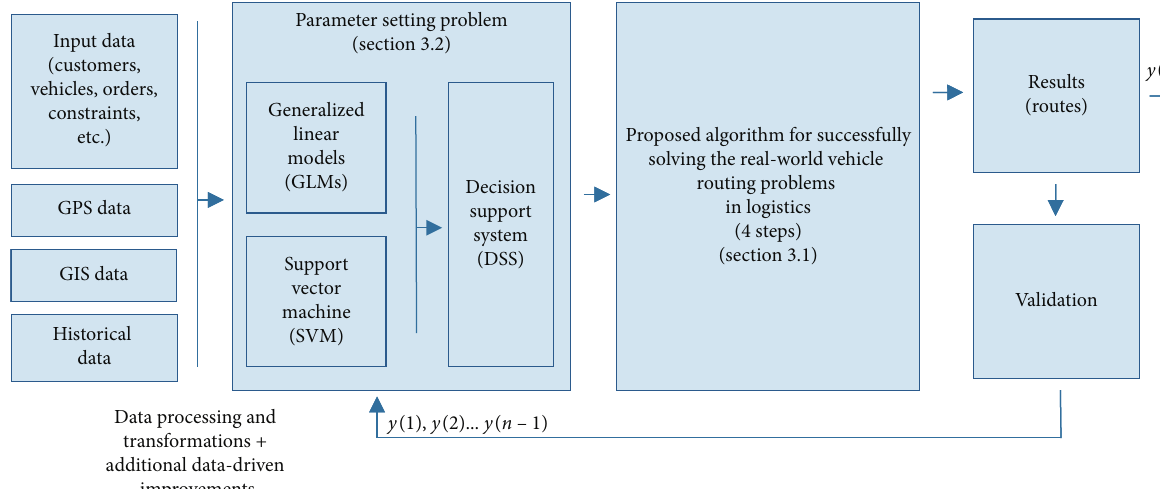
Figure 1: Proposed data-driven approach for adaptive solving of the vehicle routing